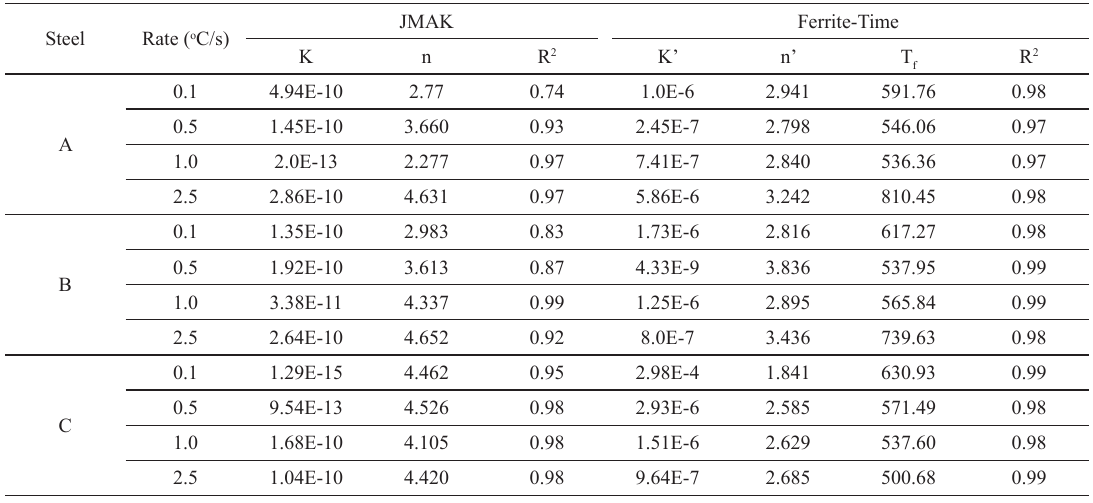
Table 5. Kinetics constants calculated through the fitting of Equations 3 and 4 to the experimental data measured for steels A, B and C. JMAK Steel Rate ( o C/s)